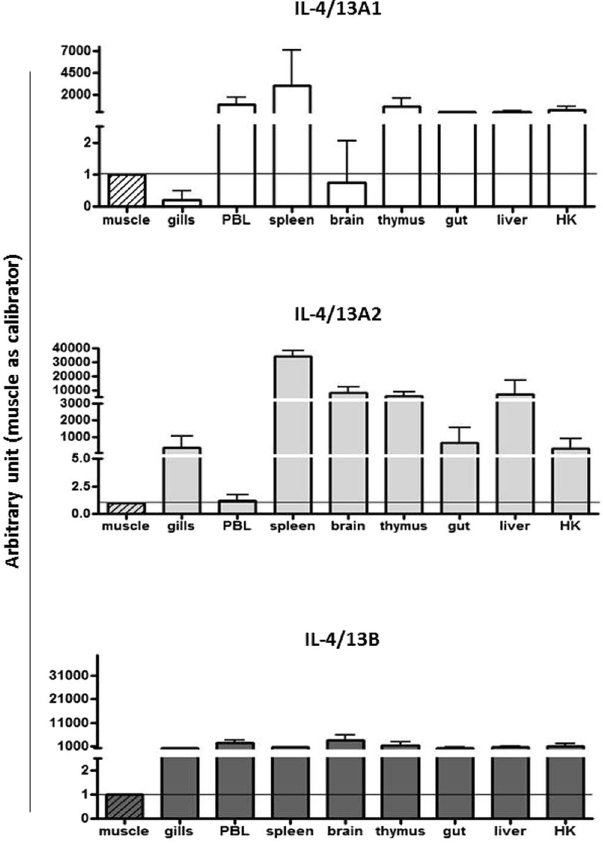
Figure 3. The basal expression of sea bass IL-4/13 isoforms in different tissues. Sea bass IL-4/13 mRNA levels were first normalised to that of 18S rRNA in the same tissue after real-time PCR analysis, and expressed as arbitrary unit using the expression level in the muscle as a calibrator (1 unit). Data were expressed as the mean + SD of four healthy sea bass